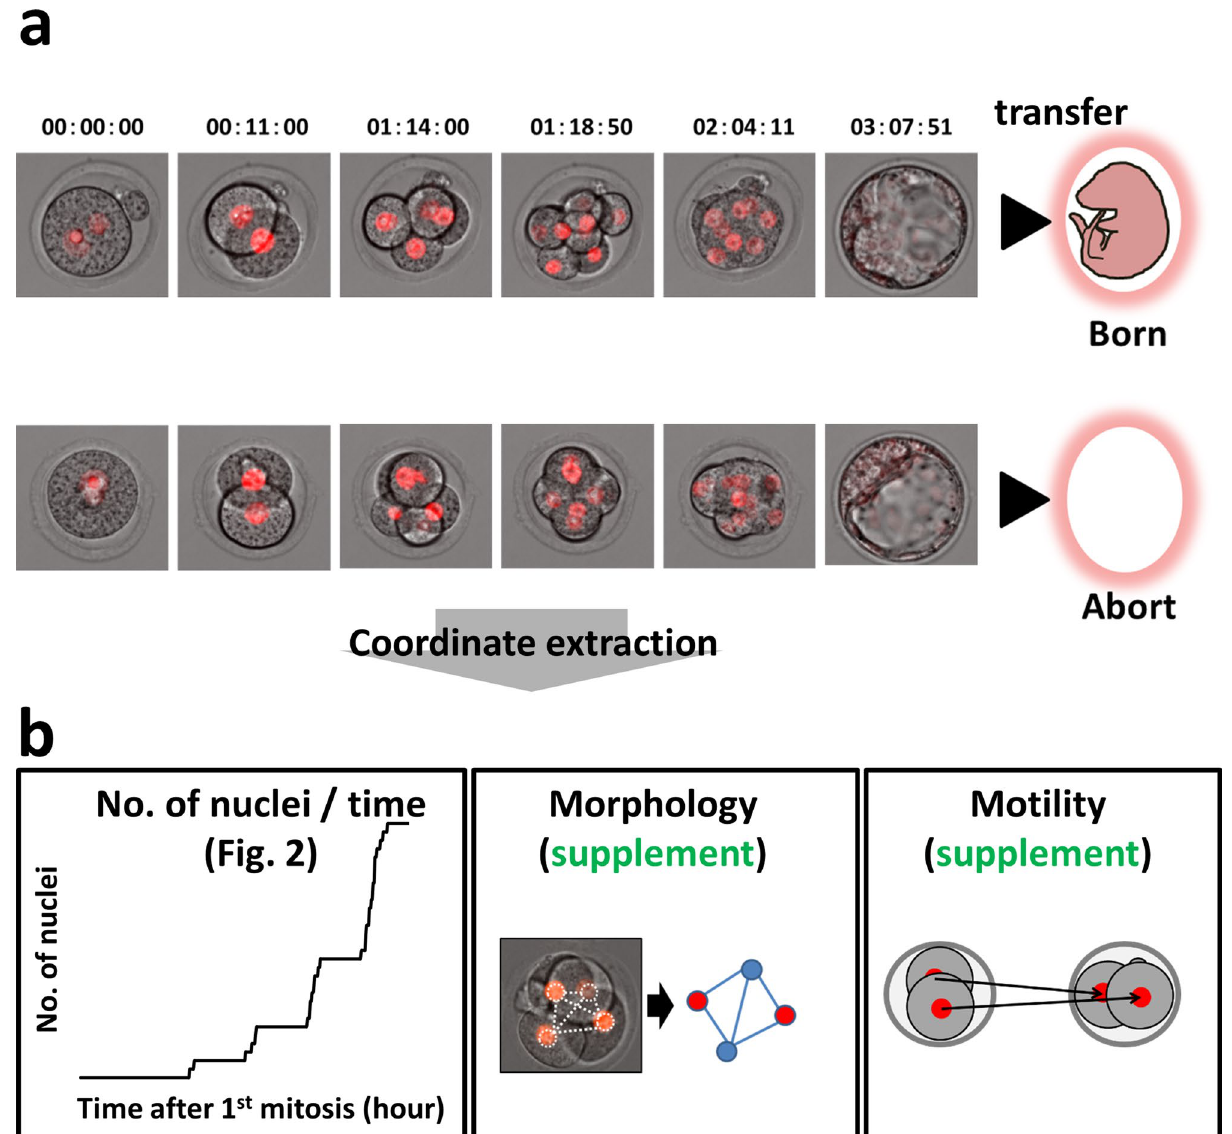
Figure 1. Comparative strategies and schemes for identifying indicators that predict embryo prognosis. ( a ) The zygote injected with the fluorescent probe histone H2B -mCherry mRNA was observed up to the blastocyst stage. Each blastocyst was transplanted into one pseudopregnant mouse, and the comparison was made retrospectively based on the transplantation results. ( b ) We measured the number of nuclei, morphology, and motility using barycentric